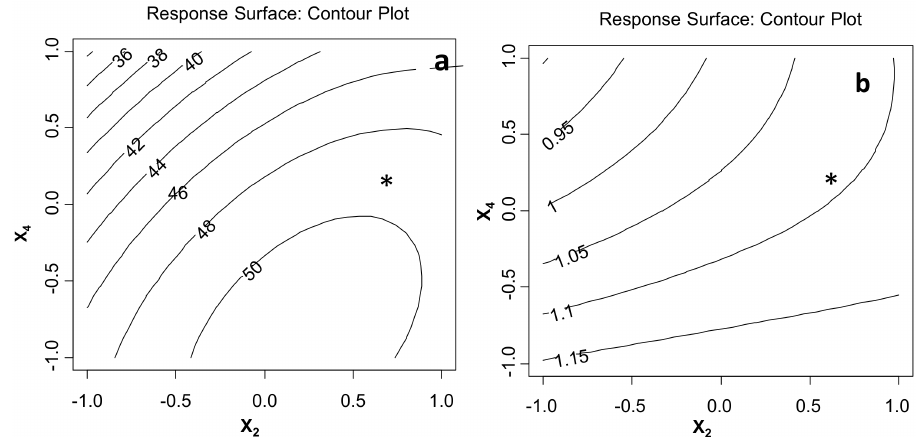
Figure 6. The Response Surface Contour Plots obtained for ( a ) Y 1 and ( b ) Y 2 and the mathematical models obtained by the Central Composite Design (X 2 , pulse; X 4 , sample/solvent ratio). * locates the selected